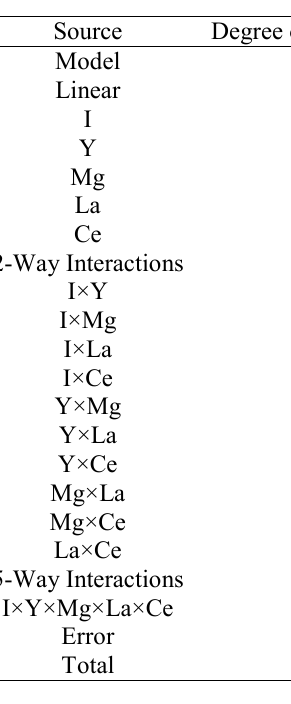
Analysis of Variance for viscosity model